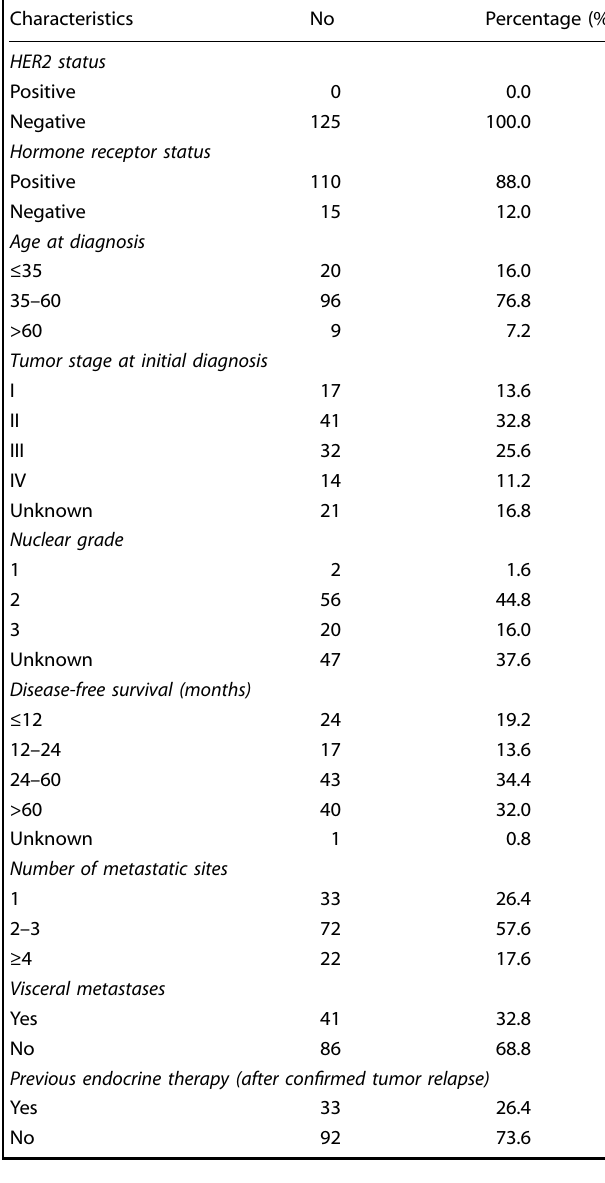
Table 1. Population characteristics ( N =